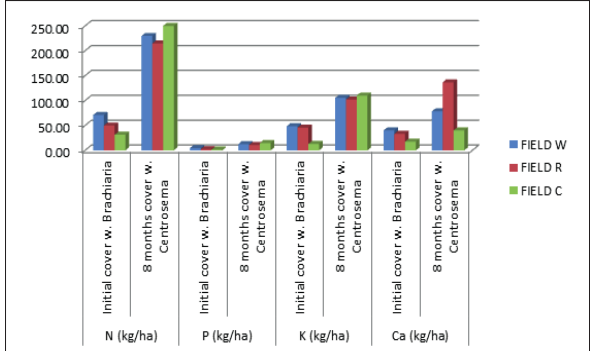
Figure 9. Mean content of N, P, K and Ca in the Centrosema biomass in three farmer’s sites in Santo Tomas, Yurimaguas.